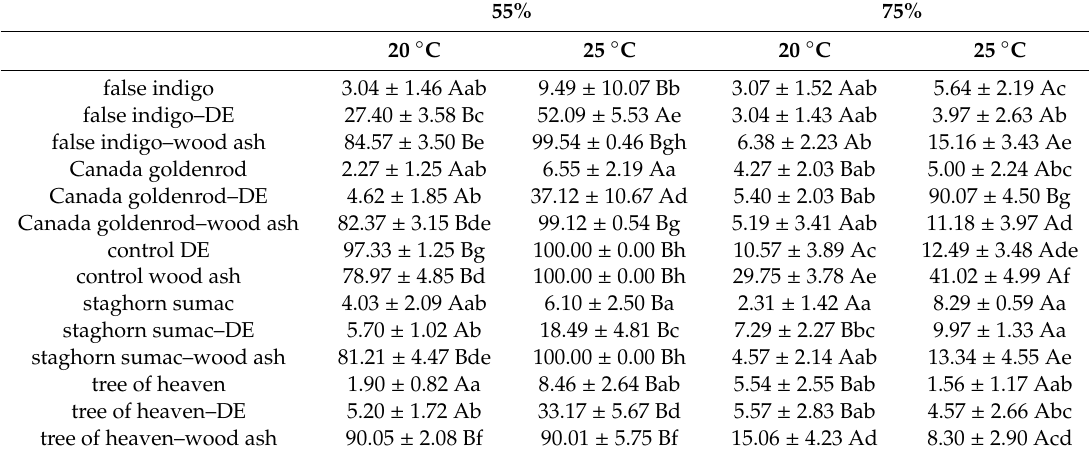
Table 8. Mean mortality (% ± SE) of Sitophilus oryzae exposed to di ff erent treatments for 21